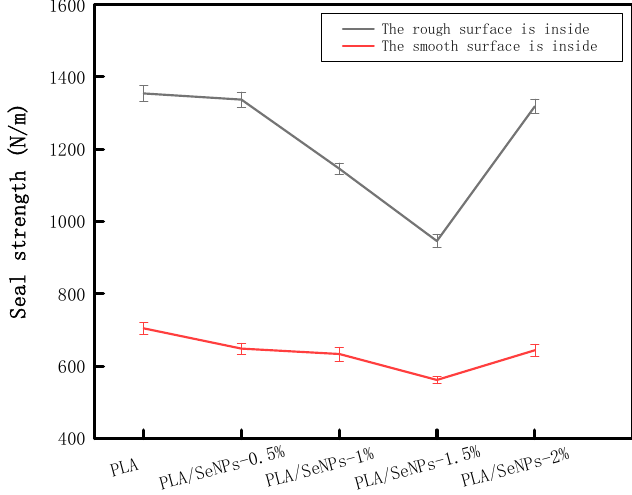
Figure 7. Seal strength of PLA and PLA / SeMPs